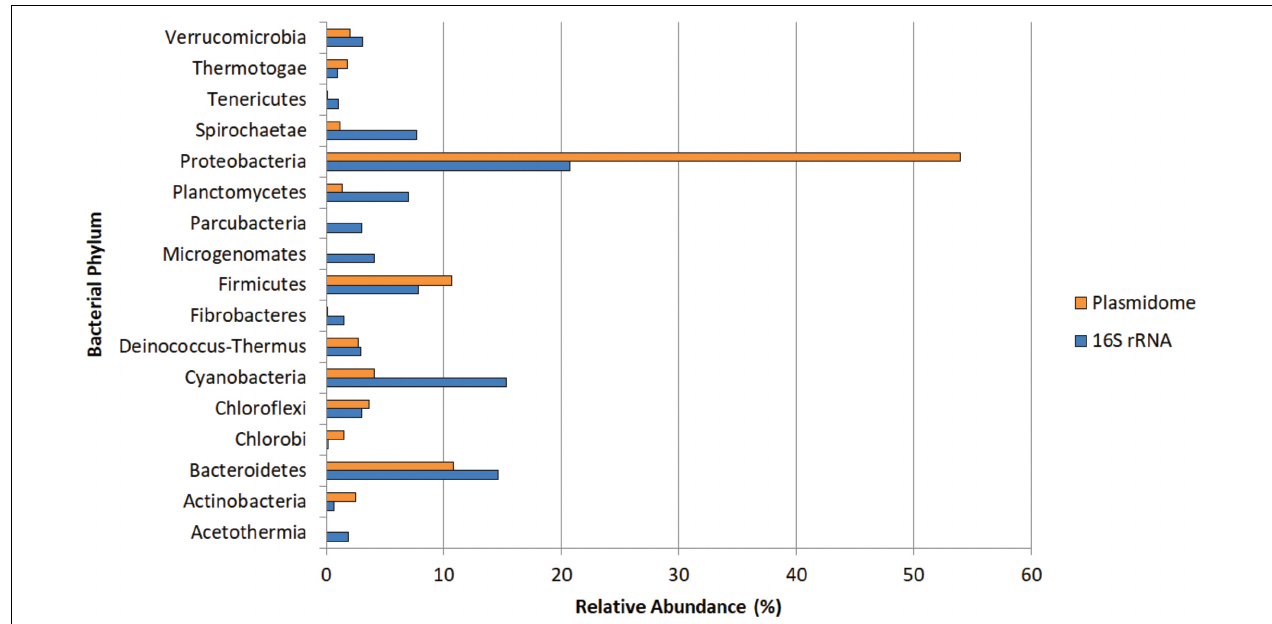
FIGURE 8 | Phylogenetic analysis of the Puquio de Campo Naranja plasmidome at the phylum level. Orange bars show the relative abundance of each bacterial phylum by MG-RAST analysis using similarity to the RefSeq database with a maximum E -value of ≤ 10 - 5 . Blue bars show the relative abundance of each bacterial phylum by metagenomic DNA analysis using amplicon sequencing of 16S rRNA gene. Phyla that were less abundant than 1% in both datasets were not included.